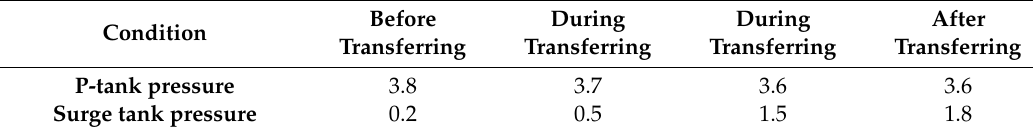
Table 4. Comparison of empirical data and simulation